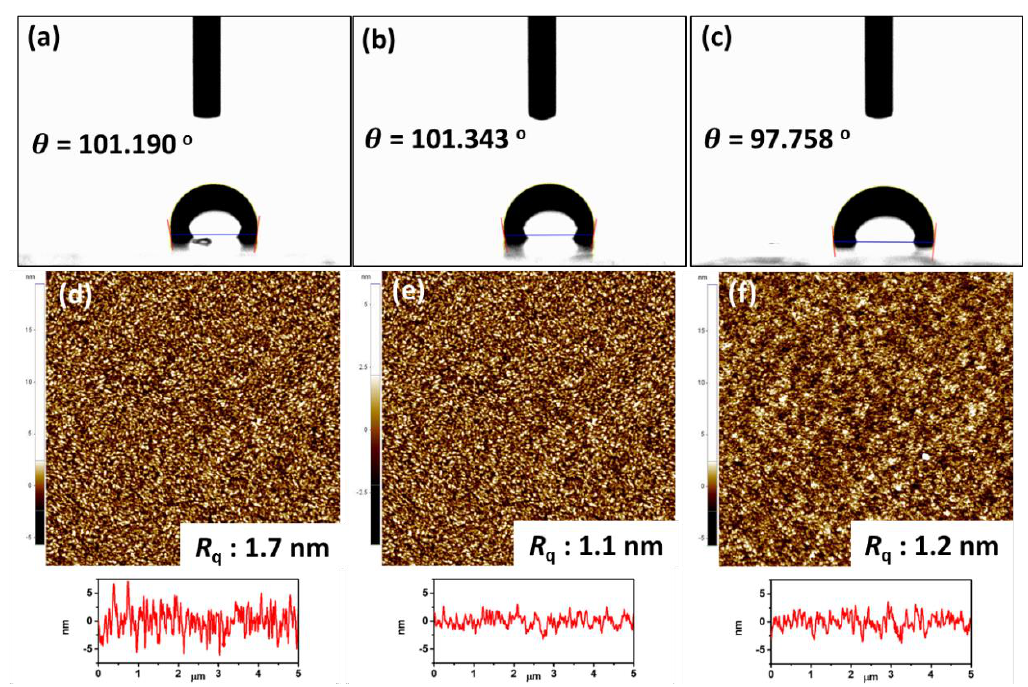
Figure 4. Water contact angle results for ( a ) pristine PSBOTz film, ( b ) pristine PBB, and ( c ) PbS-EDT film. AFM images of ( d ) PSBOTz, ( e ) PBB, and ( f ) PbS-EDT on the PbS-TBAI films.